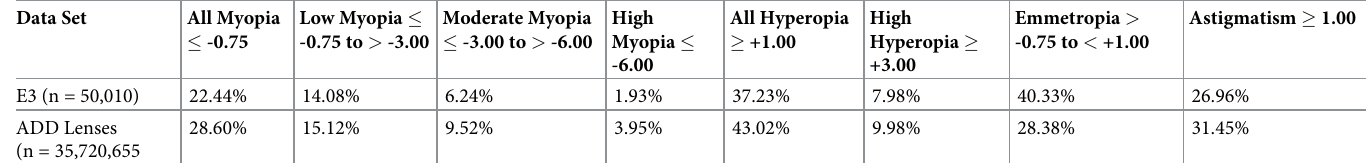
Table 5. Age matched comparison of refractive error rates between the E3 consortium and ADD lens data (mean age = 62.55 ± 8.59 years). Data Set All Myopia � -0.75